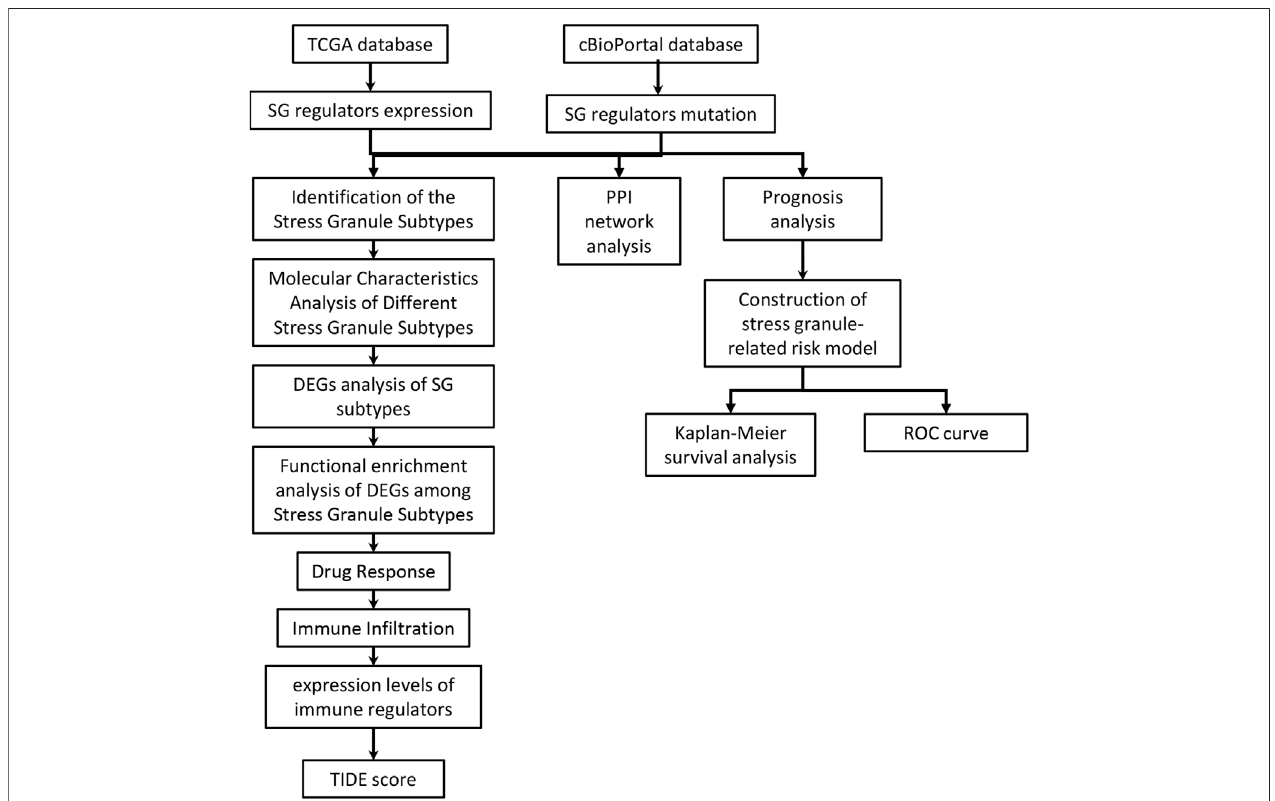
FIGURE 1 | The work fl ow for the analysis of this study was presented in fi gure.